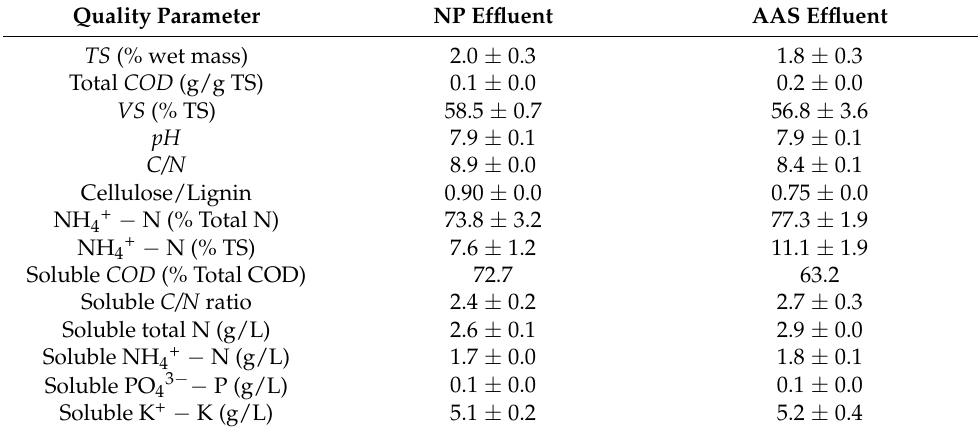
Table 4. Quality parameters of NP and AAS digester effluents for soil application. Quality